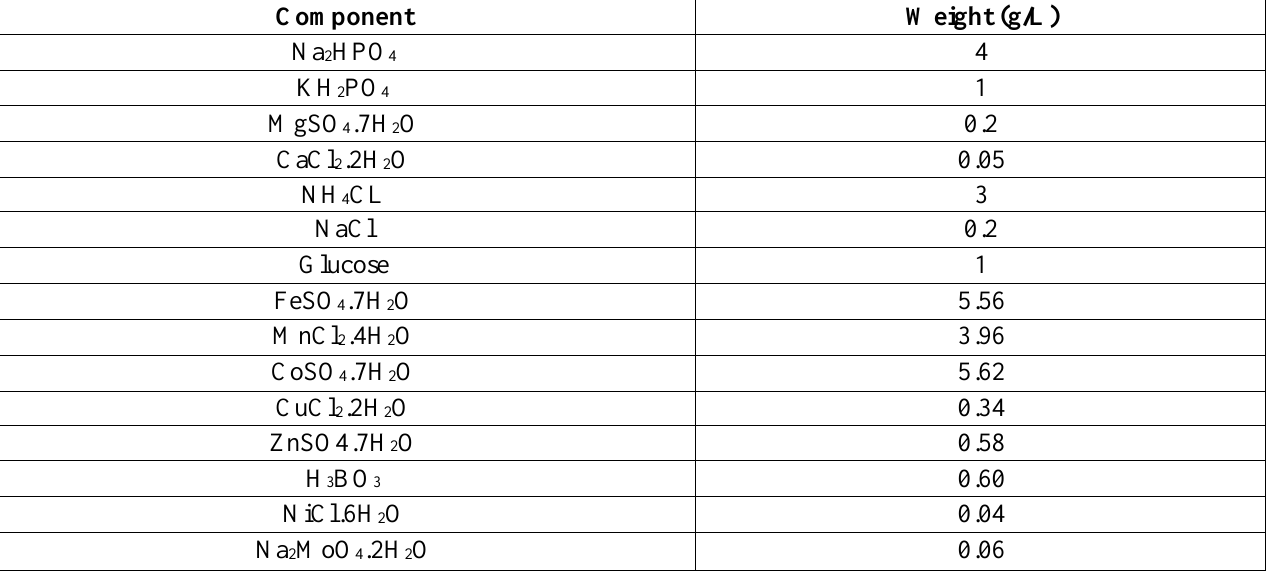
Table 1: Mineral salt medium composition (per litre distilled water).